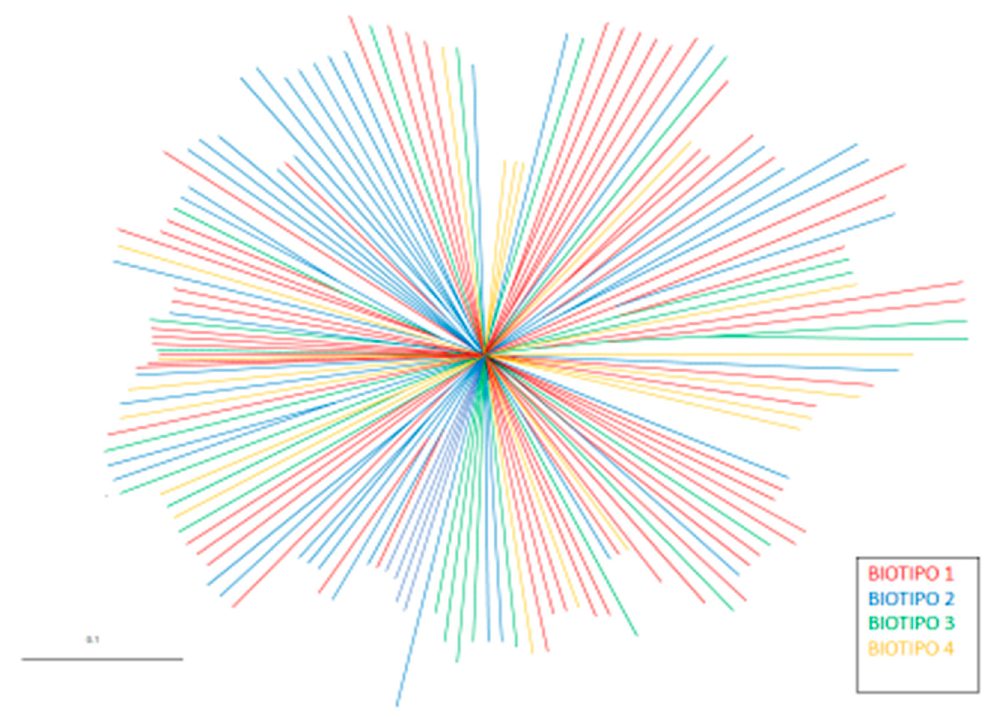
Figure 1. Tree diagram of the individual genetic distances (D SA ).